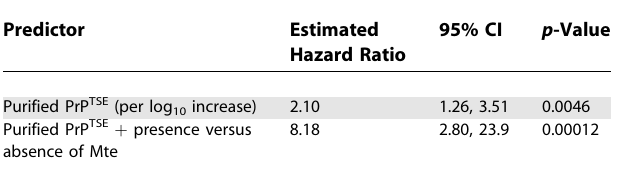
Table 2. Estimated Hazard Ratios due to Prion Dose and Mte Addition